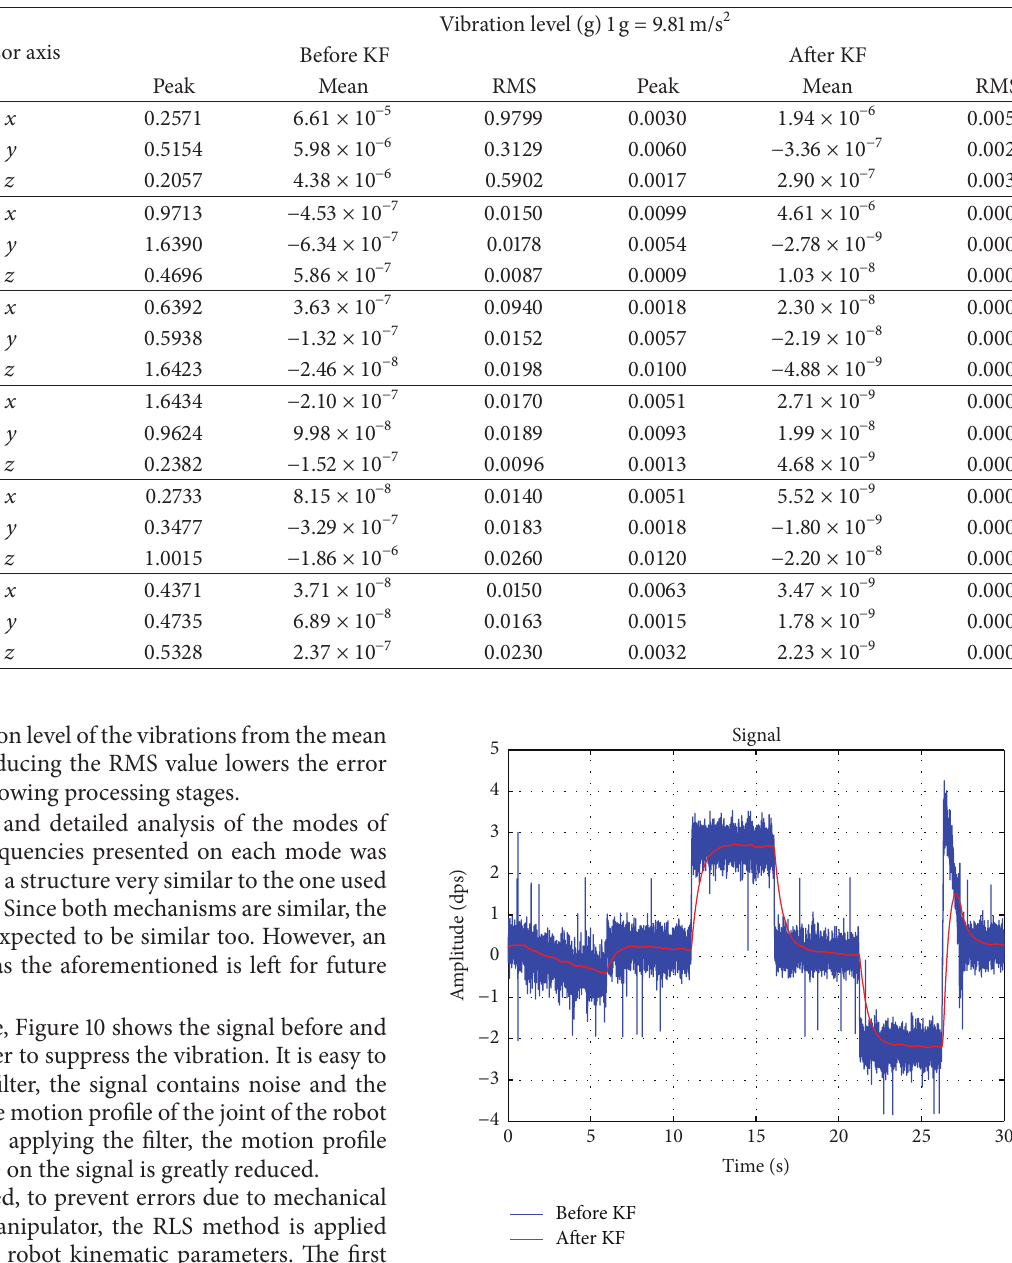
Figure 10: Signals from gyroscope before and after